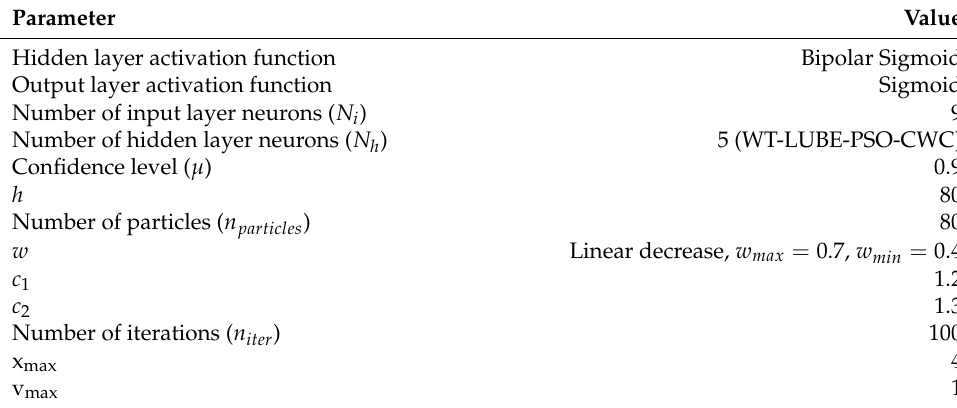
Table 2. Optimal values of the BELM ’s hyperparameters.